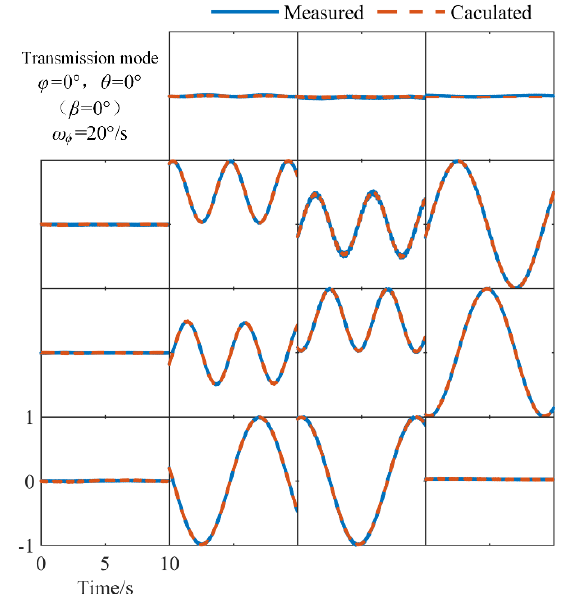
Figure 5 Normalized Muller matrix of the waveplate versus time in the normal incidence dynamic experiment in the transmission mode.